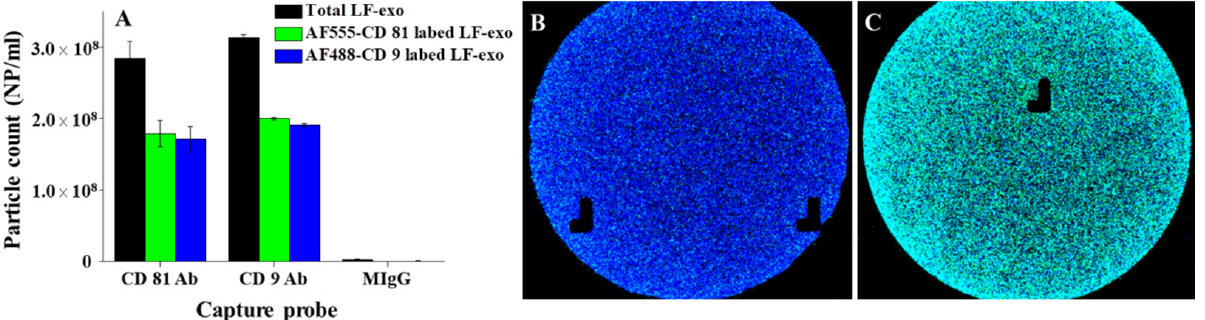
Figure 3. Tetraspanin characterization of PC-exosomes: ( A ) concentration of LF-exos and FL images of a dye-tetraspanin-labeled exosome ( B ) on a CD81 capture spot and ( C ) on a CD9 capture spot.